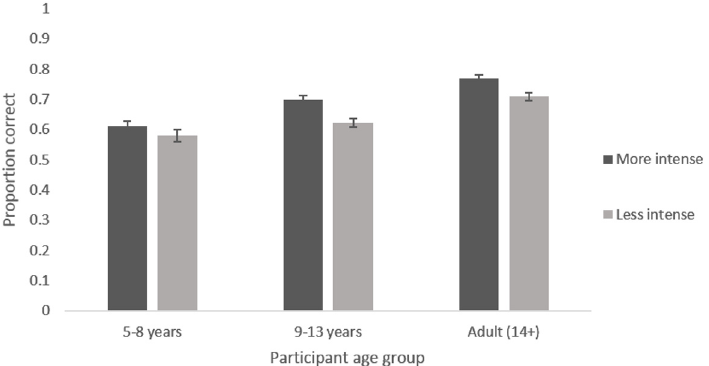
Fig 5. Mean proportion of correct responses to images at each intensity level by each participant age group. Error bars show standard error.